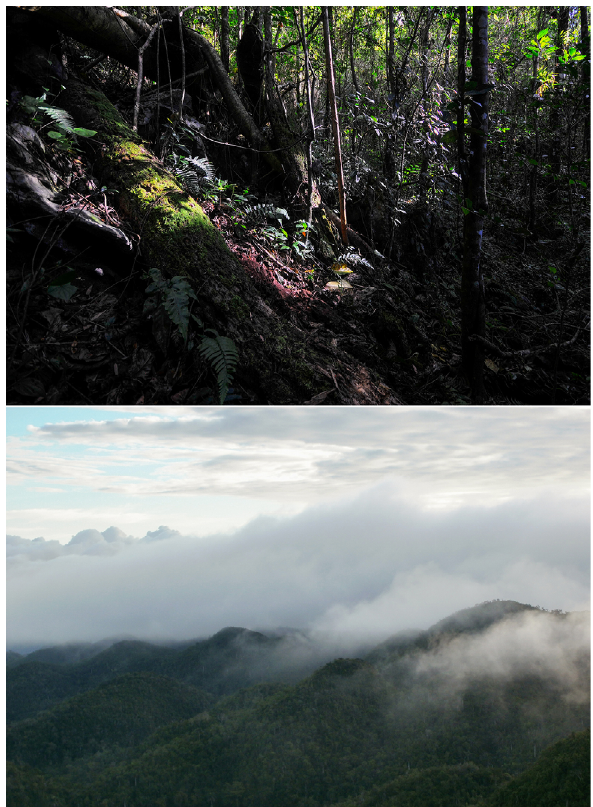
Figure 3. Habitat (above) and landscape (below) in Pico San Juan Ecological Reserve, Cienfuegos province, where a female Epilobocera capolongoi carrying offspring was observed in mountain rainforest at 1,000 m